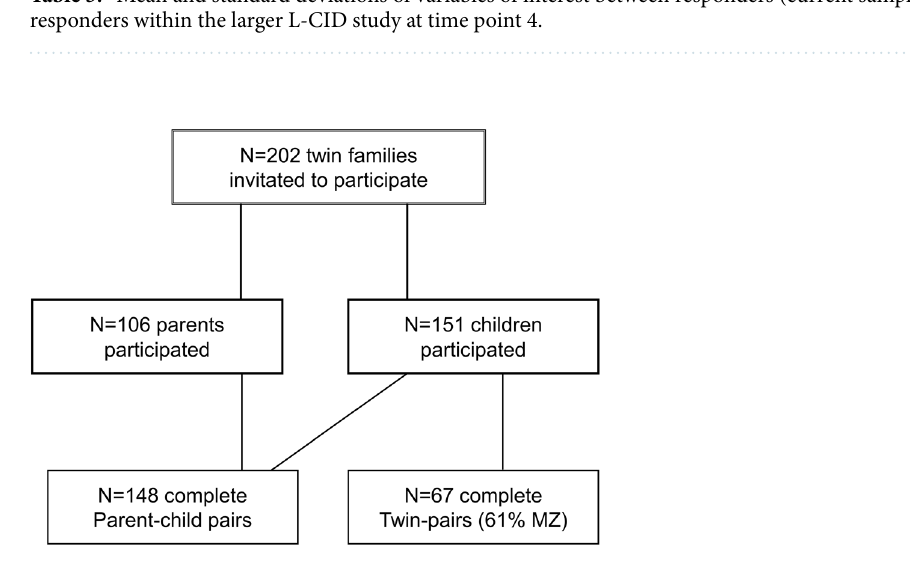
Figure 6. Flowchart of participating parents and children. The contacted families were part of the longitudinal L-CID study of the middle childhood cohort (MCC) and consisted of all families that were enrolled in the L-CID study 1